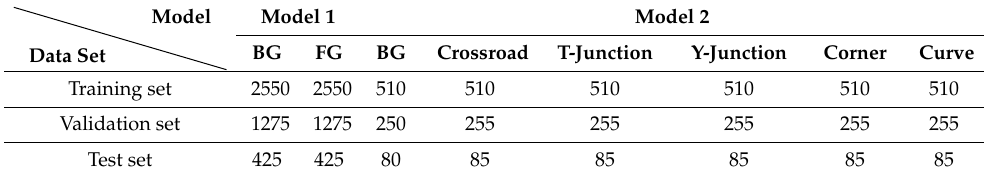
Table 2. The numbers of images of training, validation and test sets for the